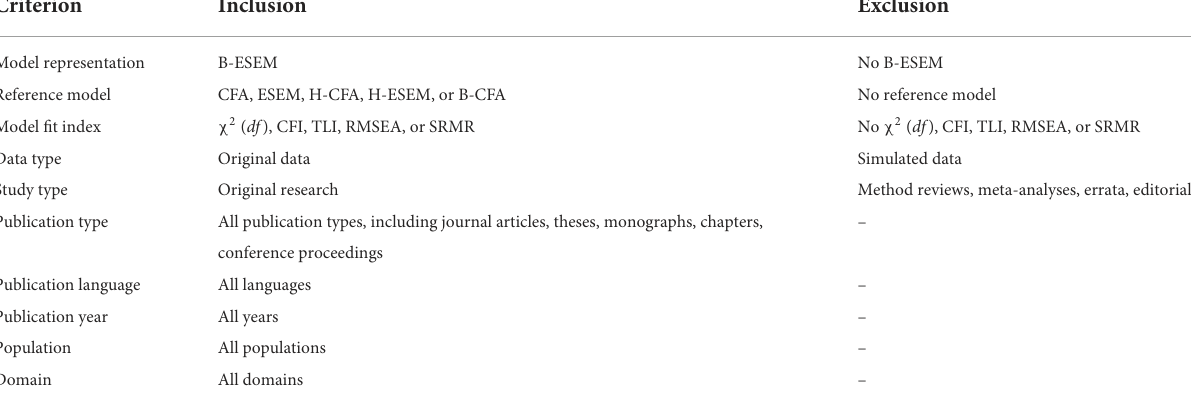
TABLE 2 Criteria for inclusion and exclusion in the meta-analytic